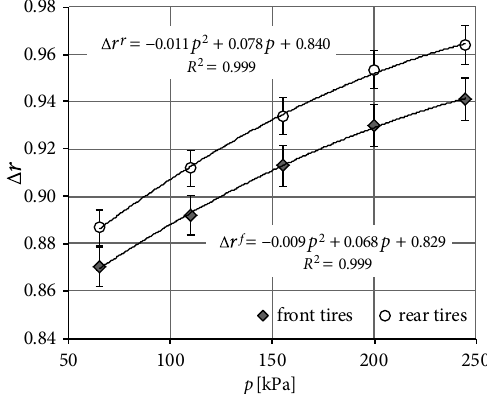
Fig. 2. Front and rear wheel tires deformation coefficient dependences on air pressure in the tires for the tractor driving at a speed of 1.43